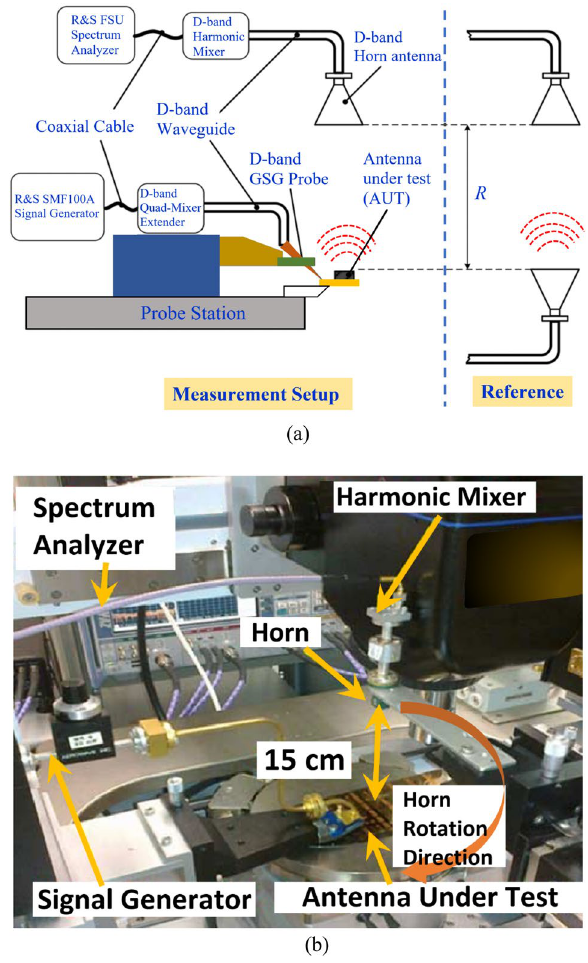
Figure 3. ( a ) Diagram of the on-wafer measurement setup for the power gain test. ( b ) Photograph of the on-wafer gain measurement